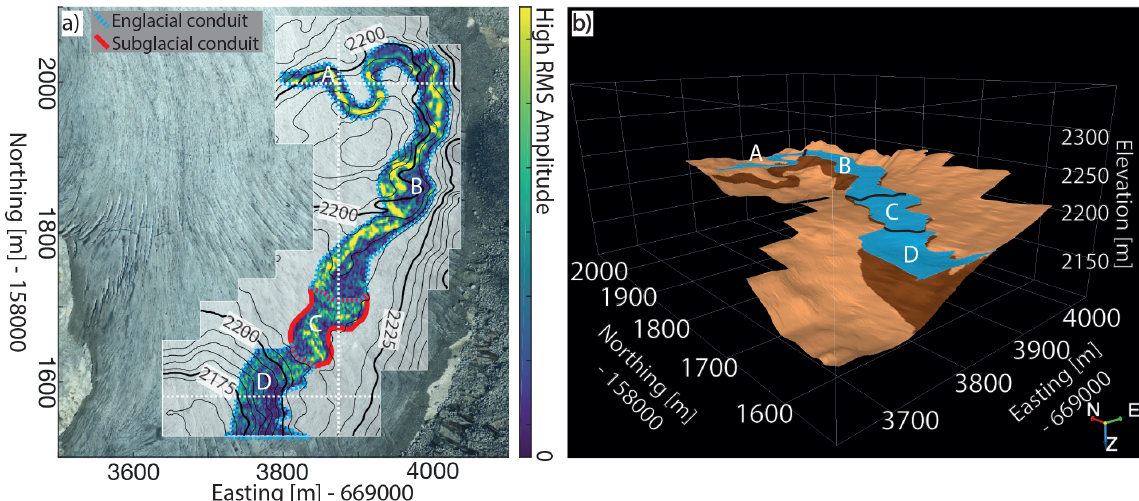
Figure 4. (a) The root-mean-squared amplitude, extracted from the picked glacial drainage network, within ± 1m of the drainage network. Contours represent the basal topography picked from the 3D GPR processed data. Colours of the drainage network represent the reflected amplitudes, and areas of high amplitude indicate the presence of water. (b) A 3D view of basal interface (brown) and drainage network (blue). The drainage network is split into four components, labelled A to D and referred to in the text. Orthophoto was provided by Swiss Federal Office of Topology. Reproduced by permission of swisstopo (JA100120), © 2020 swisstopo